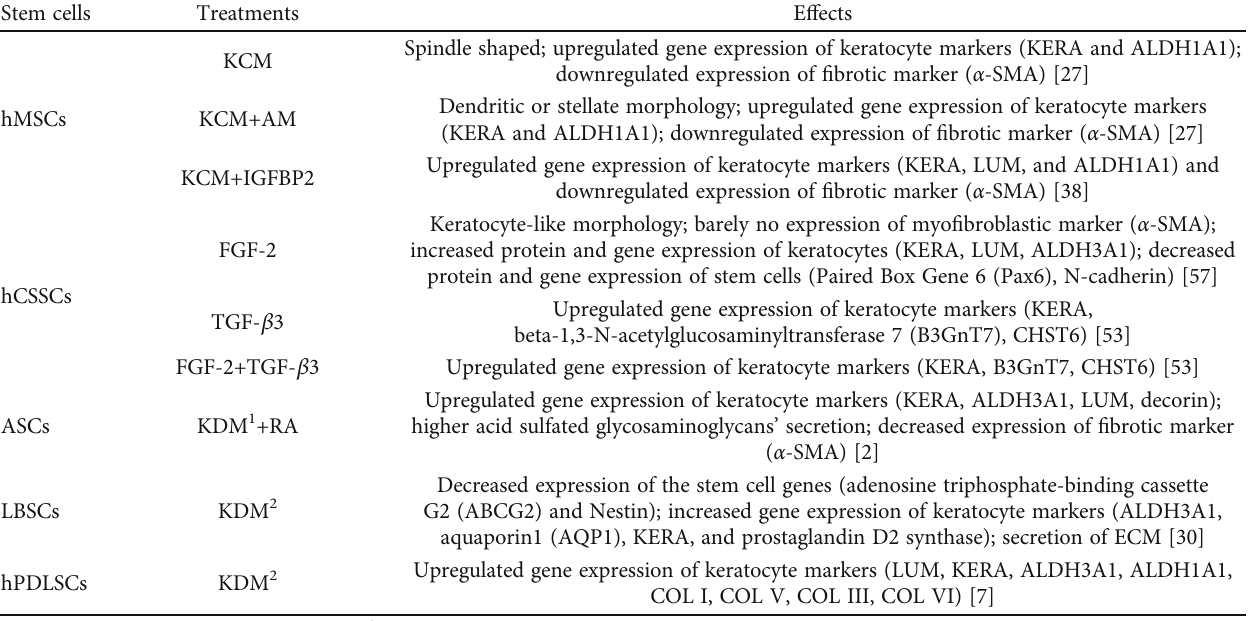
Figure 2: Current strategies for directing stem cells into keratocytes. (1) Dome-shaped mechanical stimulation; (2) topography; (3) growth factors; (4) keratocyte-conditioned medium Table 2: Biochemical stimulation induces keratocyte di ff erentiation.